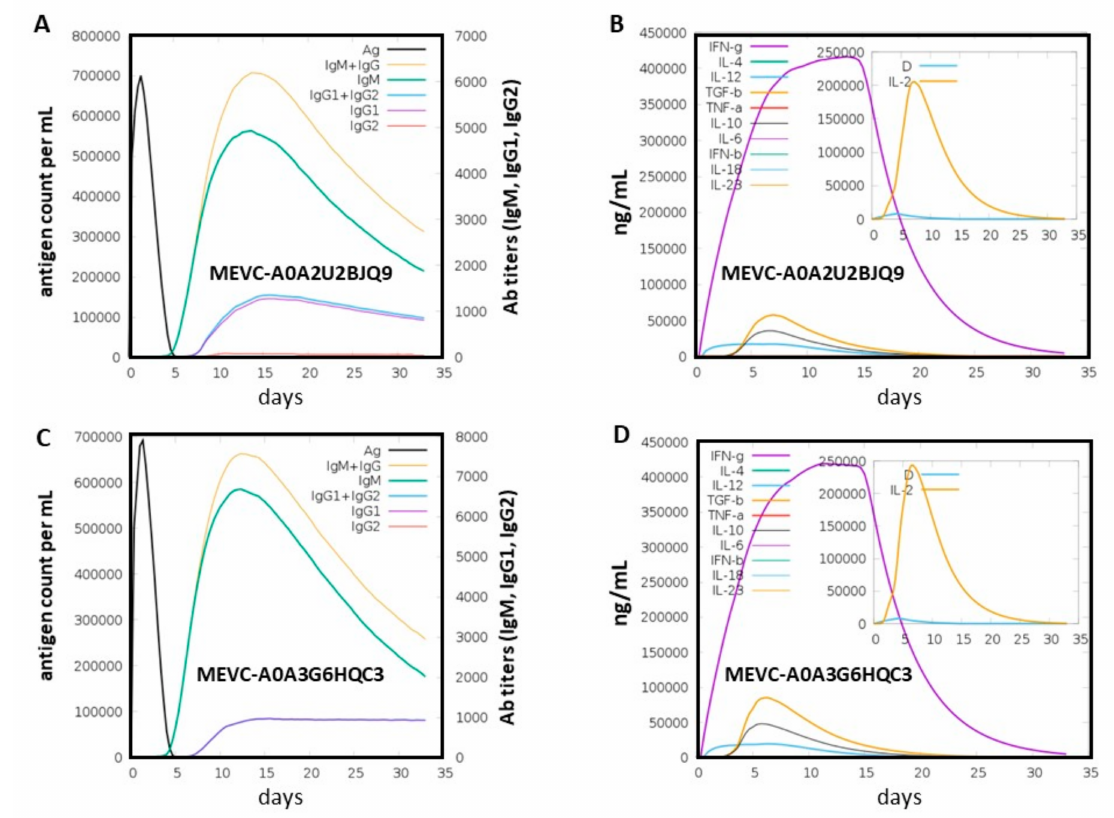
Figure 6. The evaluation of highly antigenic epitope-based vaccine designs against the two target proteins of Alcaligenes faecalis . Figures ( A , B ) show the immune simulation graphs obtained for MEVC-A0A2U2BJQ9, showing the putative antigen count/mL/day plotted against Ab titers and also cytokines and interleukins production against the target protein. Similarly, figures ( C , D ) show the immune simulation graphs obtained for MEVC-A0A3G6HQC3 representing the putative immune response in the form of produced Ab titers, cytokines, and IFN responses against the protein target- specific vaccine